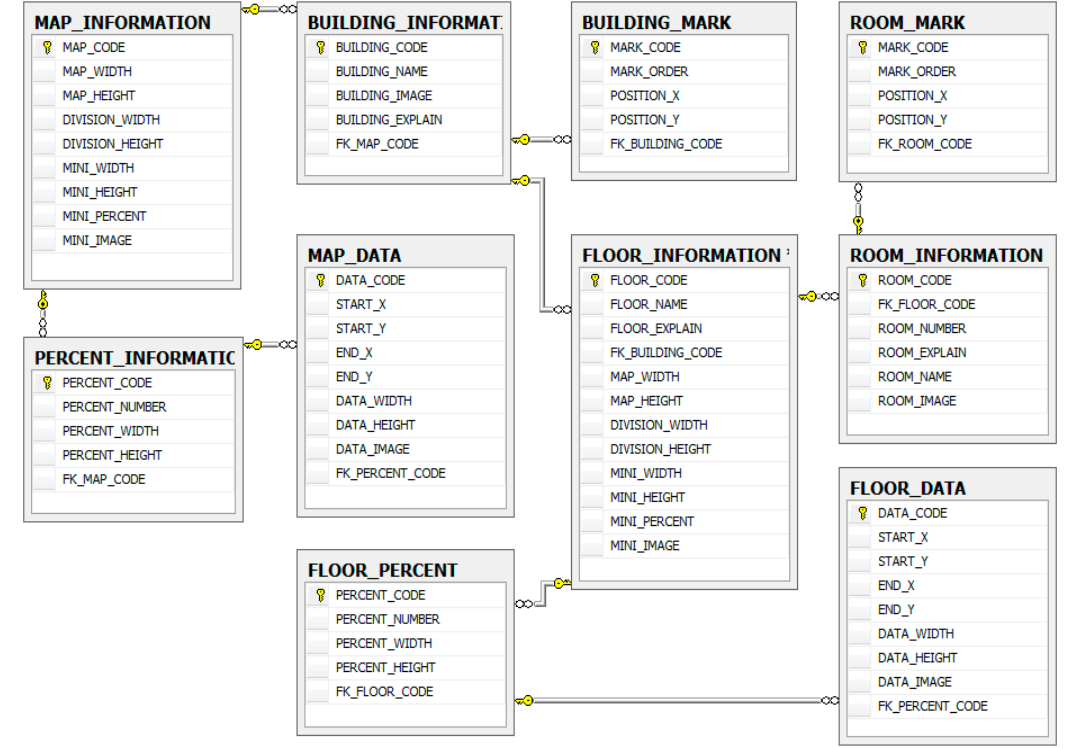
Figure 9. Geo database relationship diagram.